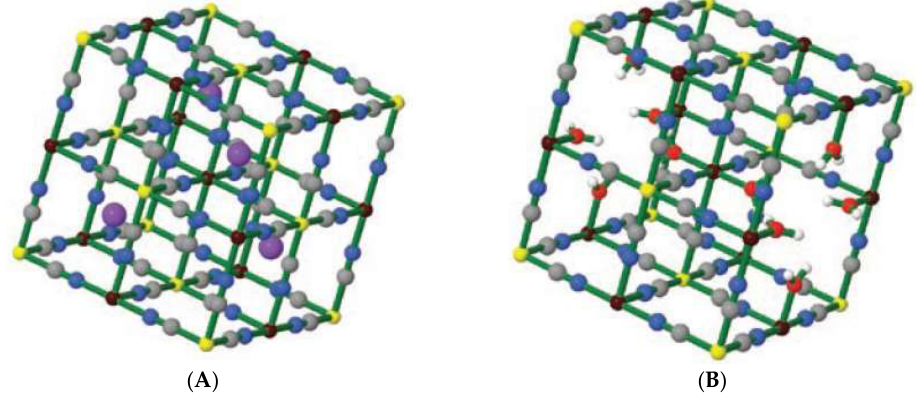
Figure 1. ( A ) Rendering of the lattice of ‘soluble’ PB, KFe III [Fe II (CN) 6 ], with half of the centers of the cubic cells occupied by K + . Colors: Fe II yellow, Fe III brown, C gray, N blue, K, violet; ( B ) Rendering of the lattice of ‘insoluble’ PB, Fe III 4 [Fe II (CN) 6 ] 3 , with the coordinative sphere of Fe III completed by water molecules (O red, H white). Reproduced by permission from Ref. [1].